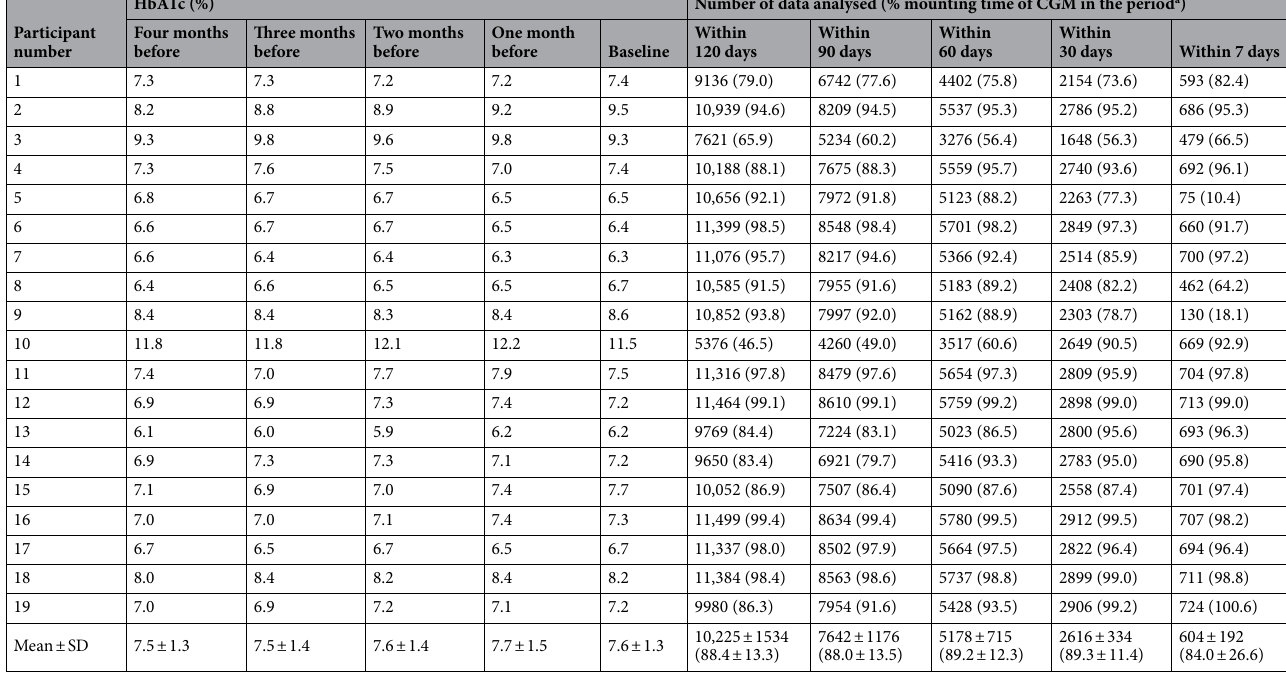
Table 3. HbA1c and number of data analyzed. CGM continuous glucose monitoring. a The number of analyzed data were divided by 11,568, 8688, 5808, 2928 corresponding to maximum points for 120.5, 90.5, 60.5, and 30.5 days, respectively, and shown as % mounting time of CGM.